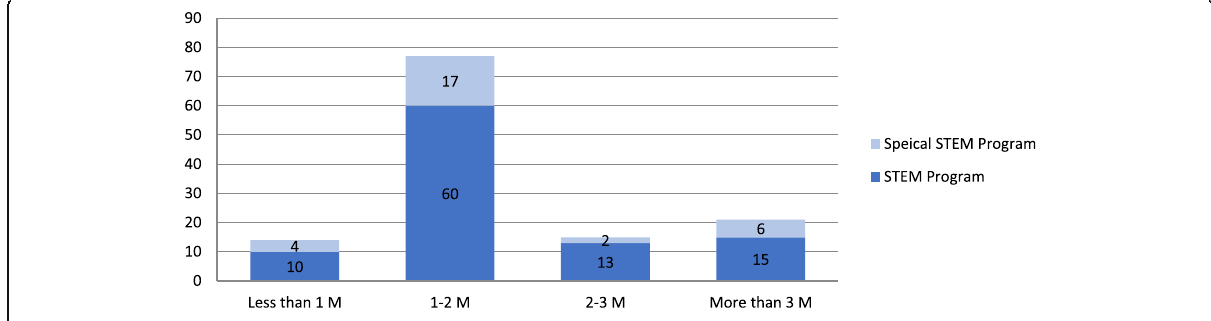
Fig. 5 The number of projects in terms of total funding amount categories